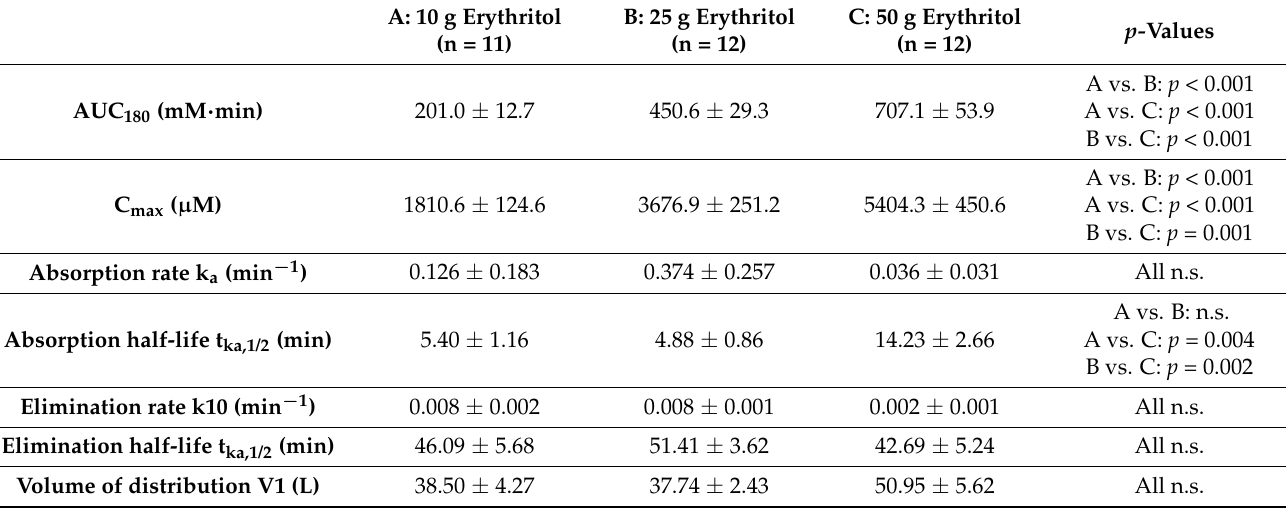
Table 1. Absorption of